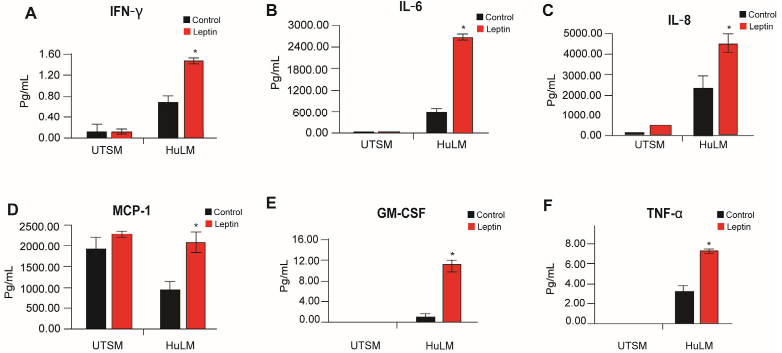
Figure 4. Effect of leptin treatment in inflammatory factors secretion in human immortalized leiomyoma and myometrium cells. Immortalized human leiomyoma and myometrium cells were treated with 100 ng/mL leptin for 48 h. After the incubation time, collected media were used to measure the secretion levels of ( A ) IFN- γ , ( B ) IL-6, ( C ) IL-8, ( D ) MCP-1, ( E ) GM-CSF, and ( F ) TNF- α . The data are presented as the mean ± standard error of the mean (SEM) from three independent experiments. *, p < 0.05 vs. control.